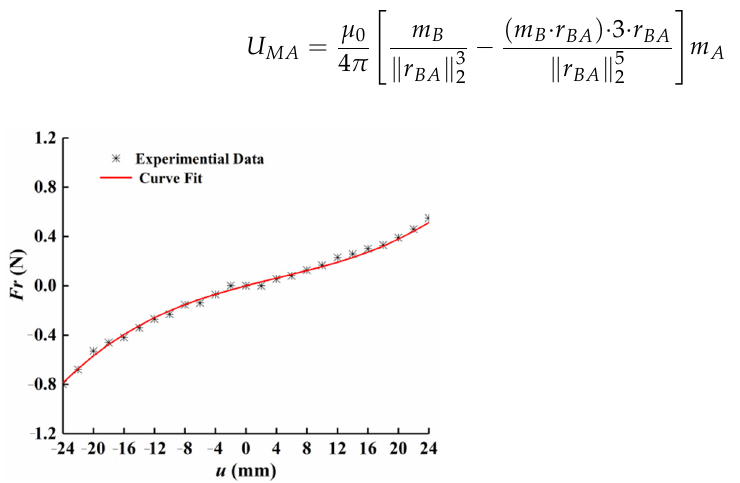
Figure 5. Displacement-restoring force curve of the curve-shaped beam.